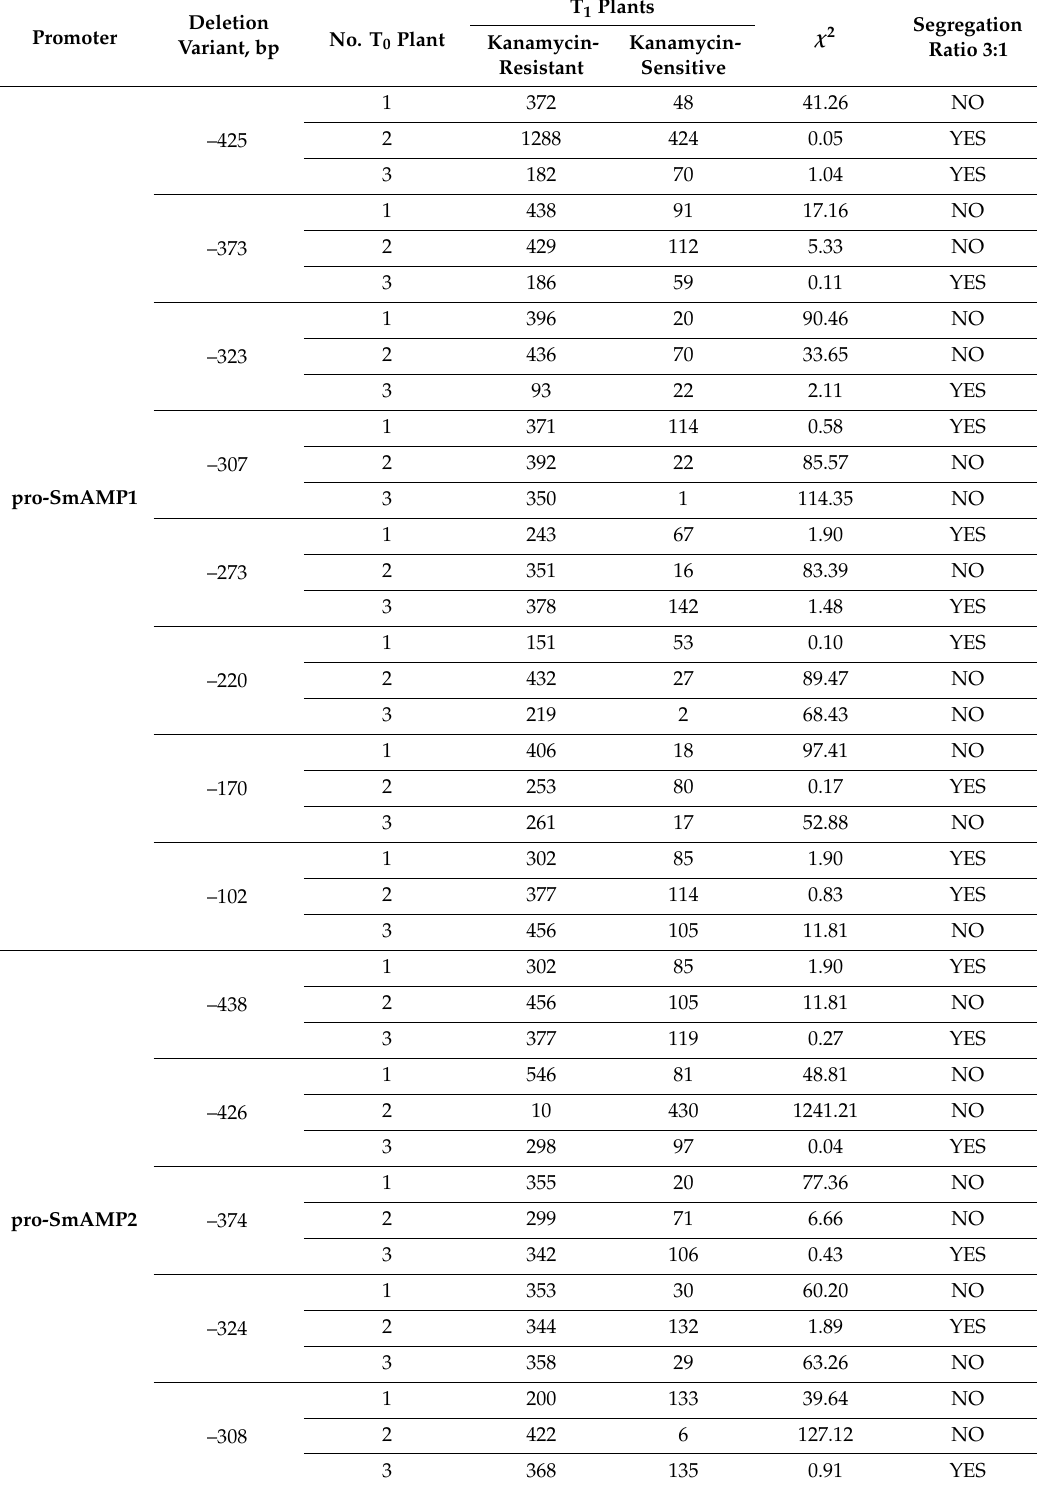
Table A2. The segregation of the T 1 tobacco plants on selective